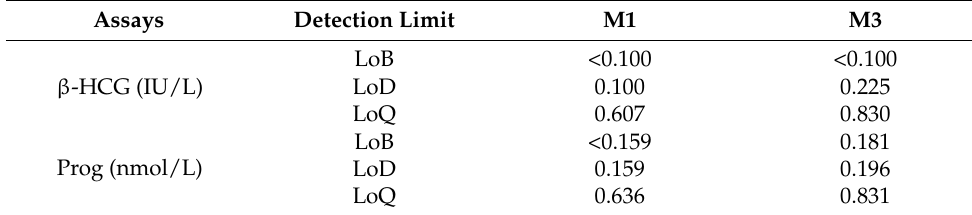
Table 4. Detection capability of